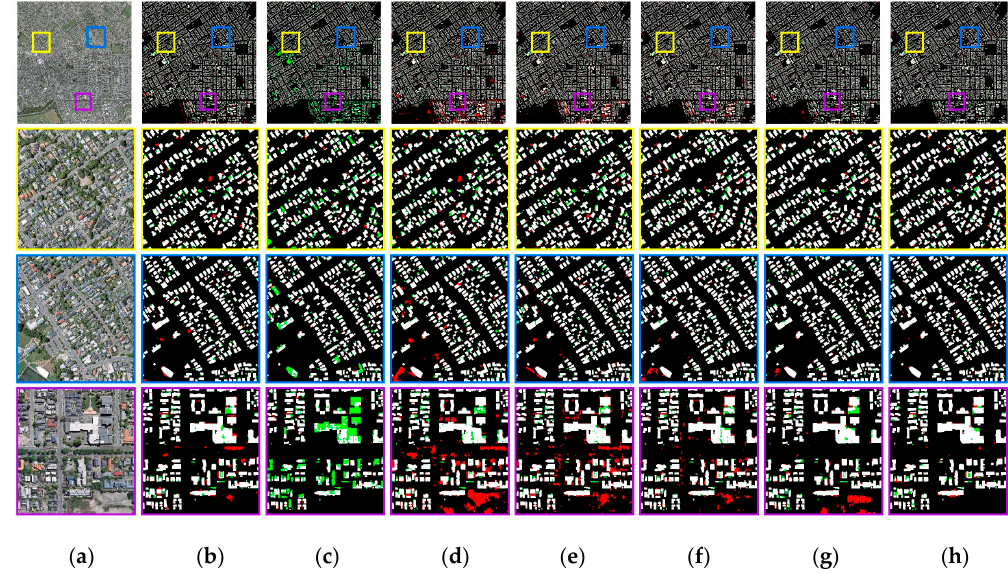
Figure 5. Visual comparison of segmentation results (an urban area of Christchurch City, New Zealand) obtained by seven approaches. The first row shows the overall results of a randomly picked test area generated by the seven networks, while the last three rows exhibit the zoomed-in results of the corresponding regions that were also randomly picked from the test area. In the colored images of the last three rows, the white, red and green colors represent true positive, false positive and false negative predictions, respectively. ( a ) Image. ( b ) FCN-8s. ( c ) SegNet. ( d ) DeconvNet. ( e ) U-Net. ( f ) ResUNet. ( g ) DeepUNet. ( h ) DeepResUnet.